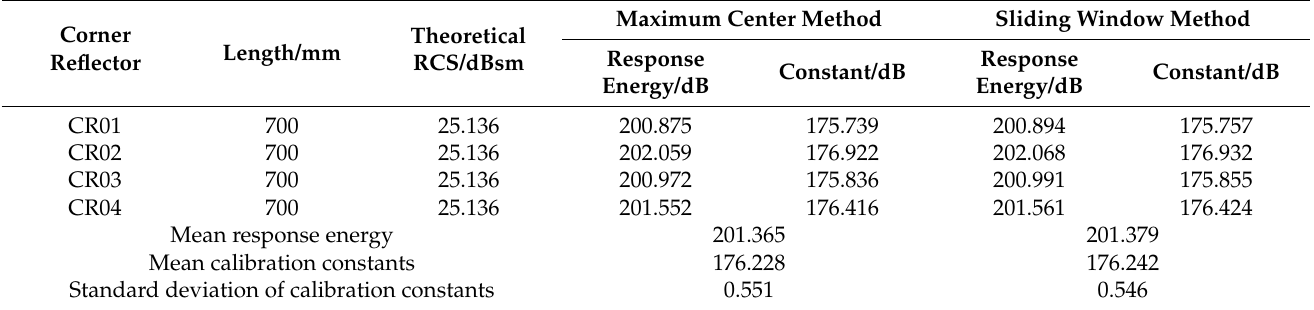
Table 9. Integral response energy and calibration constants of the point target for the maximum center method and sliding window